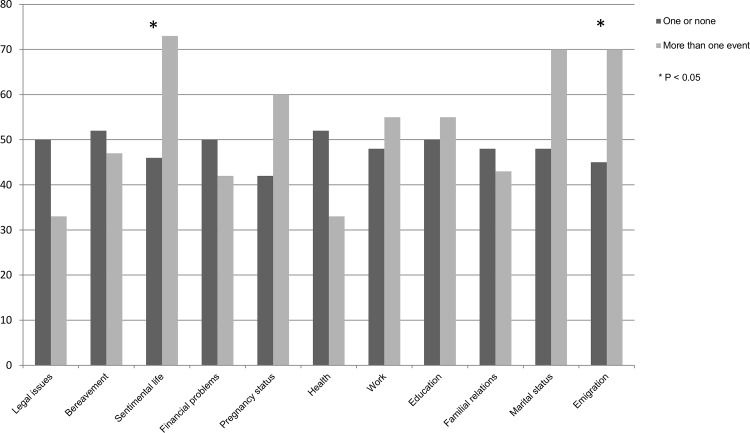
Histogram of frequencies (%) of patients with positive lymph node (N1) status by category of life stress events.Dark bars depict percentage frequencies of N1 patients who experienced repeated stress (at least one event of the category occurred more than once), light bars depict percentage frequencies of N1 patients who did not experience repeated stress (all events in the category occurred once or never). Asterisks indicate significant P-values derived from Chi-squared test.